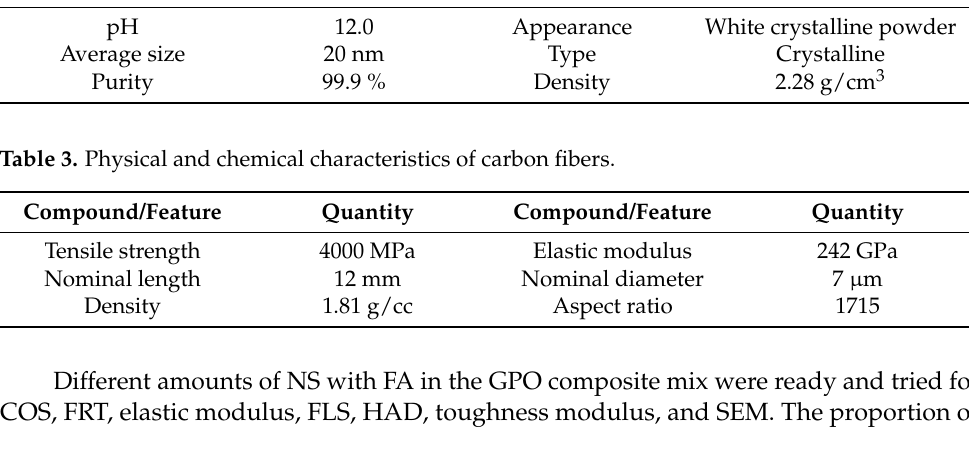
Table 3. Physical and chemical characteristics of carbon fibers.